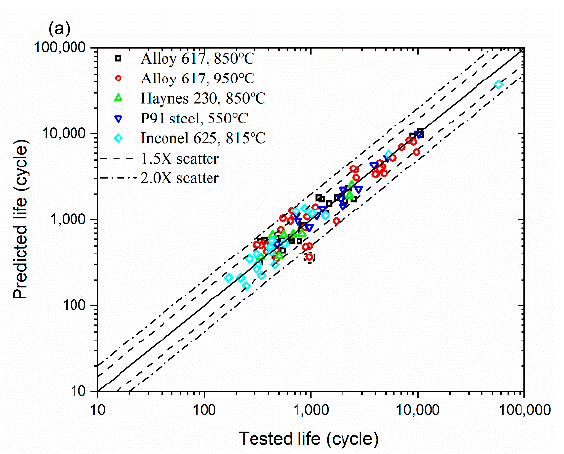
Figure 5. The relation between fatigue life and total tensile strain energy density of Inconel 625.